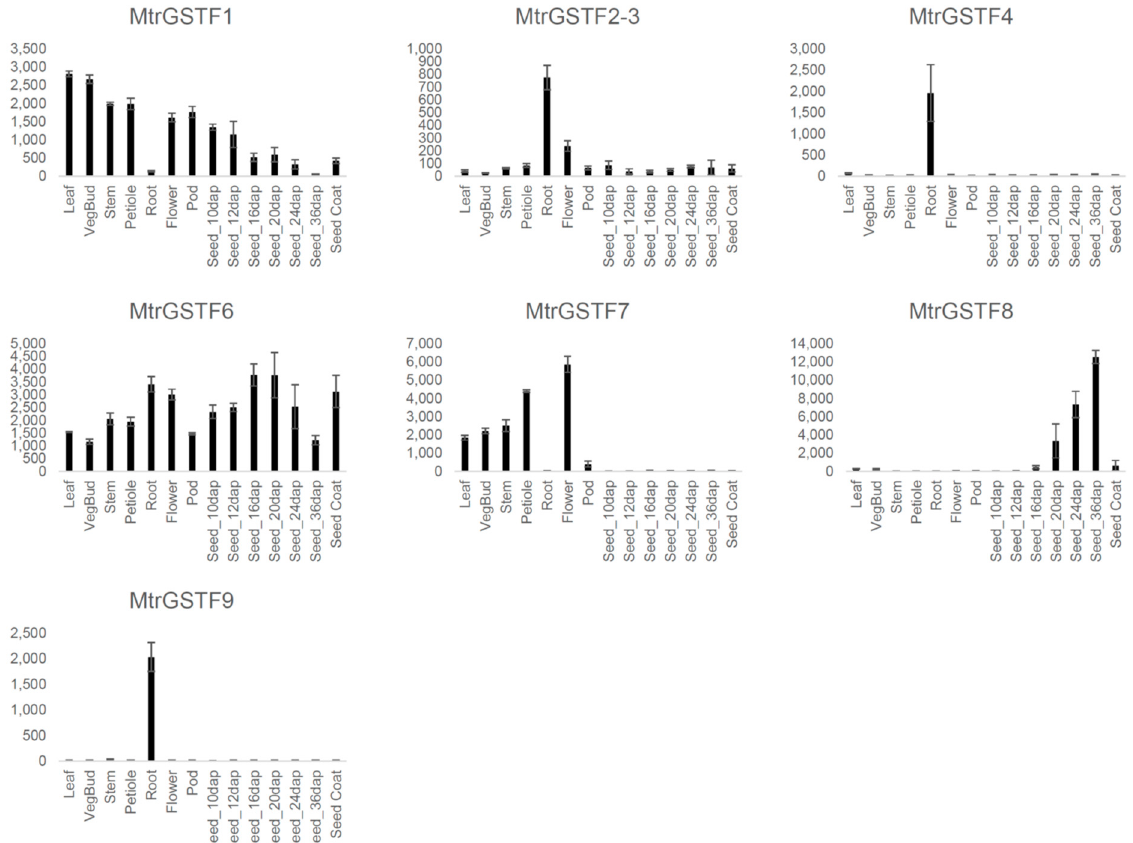
Figure 6. MtrGSTFs , expression in plant organs and in the seed coat.